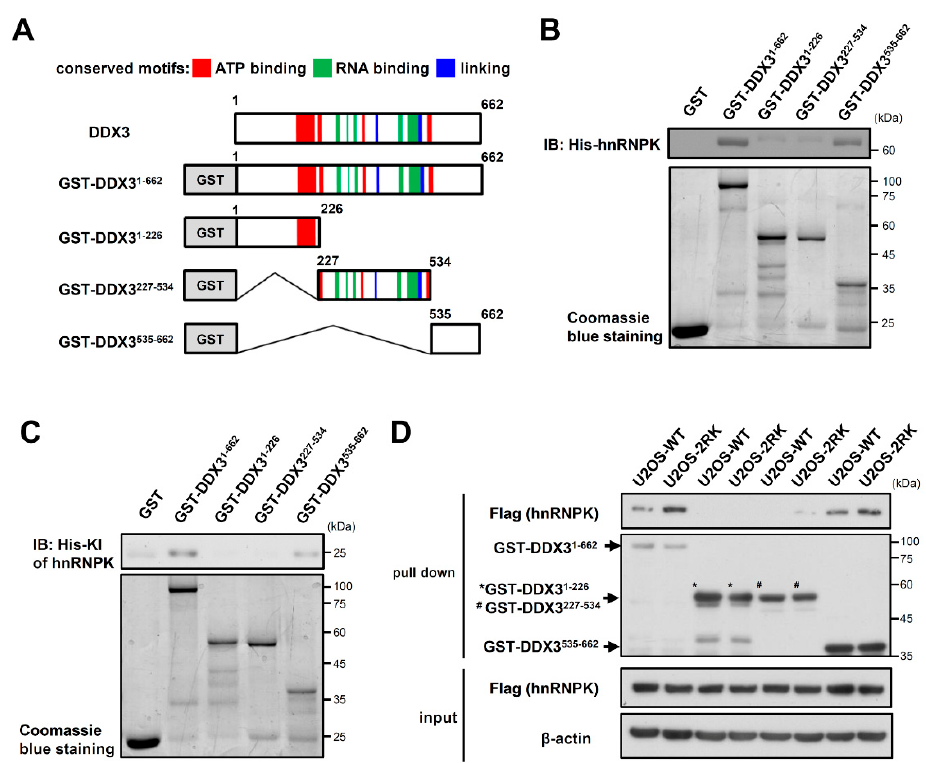
Figure 3. The C-terminal region of DDX3 is responsible for hnRNPK–DDX3 interaction. ( A ) Schematic representation of GST-DDX3 variants established in this study. The red box indicates ATP-binding motifs, the green box indicates RNA-binding motifs, and the blue box indicates the linking area between the ATP and RNA binding sites. Pull-down assays were conducted by incubating each GST-DDX3 variant with either recombinant his-hnRNPK ( B ) or his-KI ( C ), followed by SDS-PAGE to determine the interaction between hnRNPK or the KI and DDX3 variants. ( D ) U2OS-WT or U2OS-2RK cell lysates were incubated with GST-DDX3 variants in pull-down assays to determine whether the methylation of hnRNPK affects its interaction with diverse DDX3 variants. * as GST-DDX 1–226 , # as GST-DDX3 227–534 .